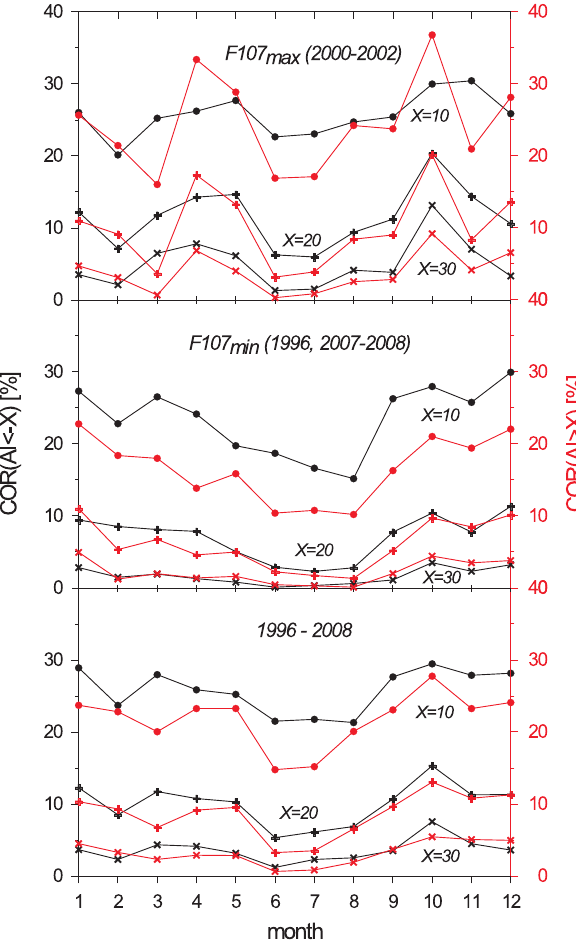
Fig. 10. Seasonal variation of the cumulative occurrence rate for negative (black) and positive hourly AI values (red) for different threshold values X separately for the full time interval (lower part), years of low (middle part) and high solar activity (upper part).